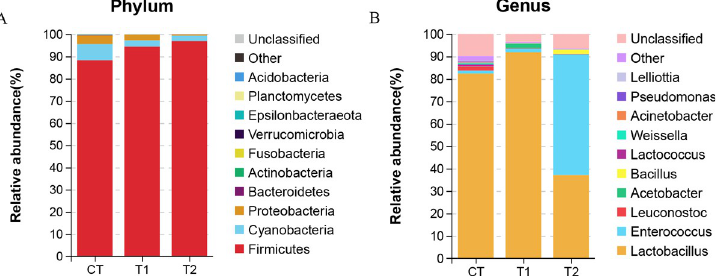
Fig 2. The relative abundance of bacteria community proportions at the phylum level (A) and genus level (B) across the treatment groups.